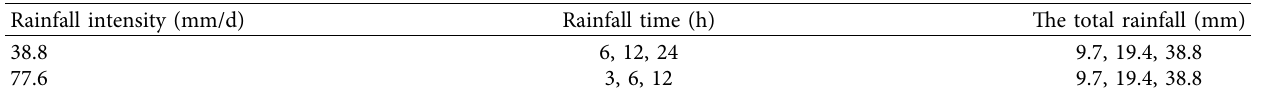
Figure 4: Construction model of embankment slope analysis section. (a) Model diagram. (b) Rainfall infiltration seepage Table 2: Simulated working condition of rain condition.